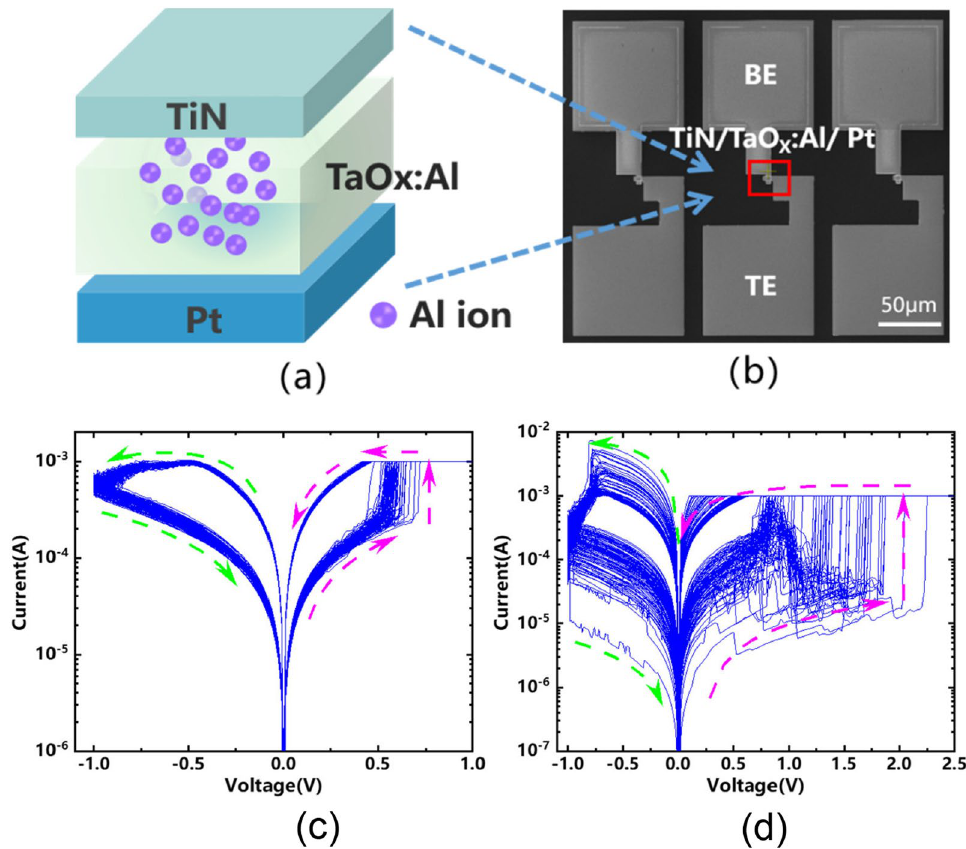
Fig. 13 a Structure diagram of Pt/Ta O x :Al/TiN RRAM b SEM image Al doped of Ta O x -based RRAM. c I–V curve of Pt/Ta O x :Al/TiN RRAM d I–V curve of Pt/Ta O x /TiN RRAM. Reproduced with permission from